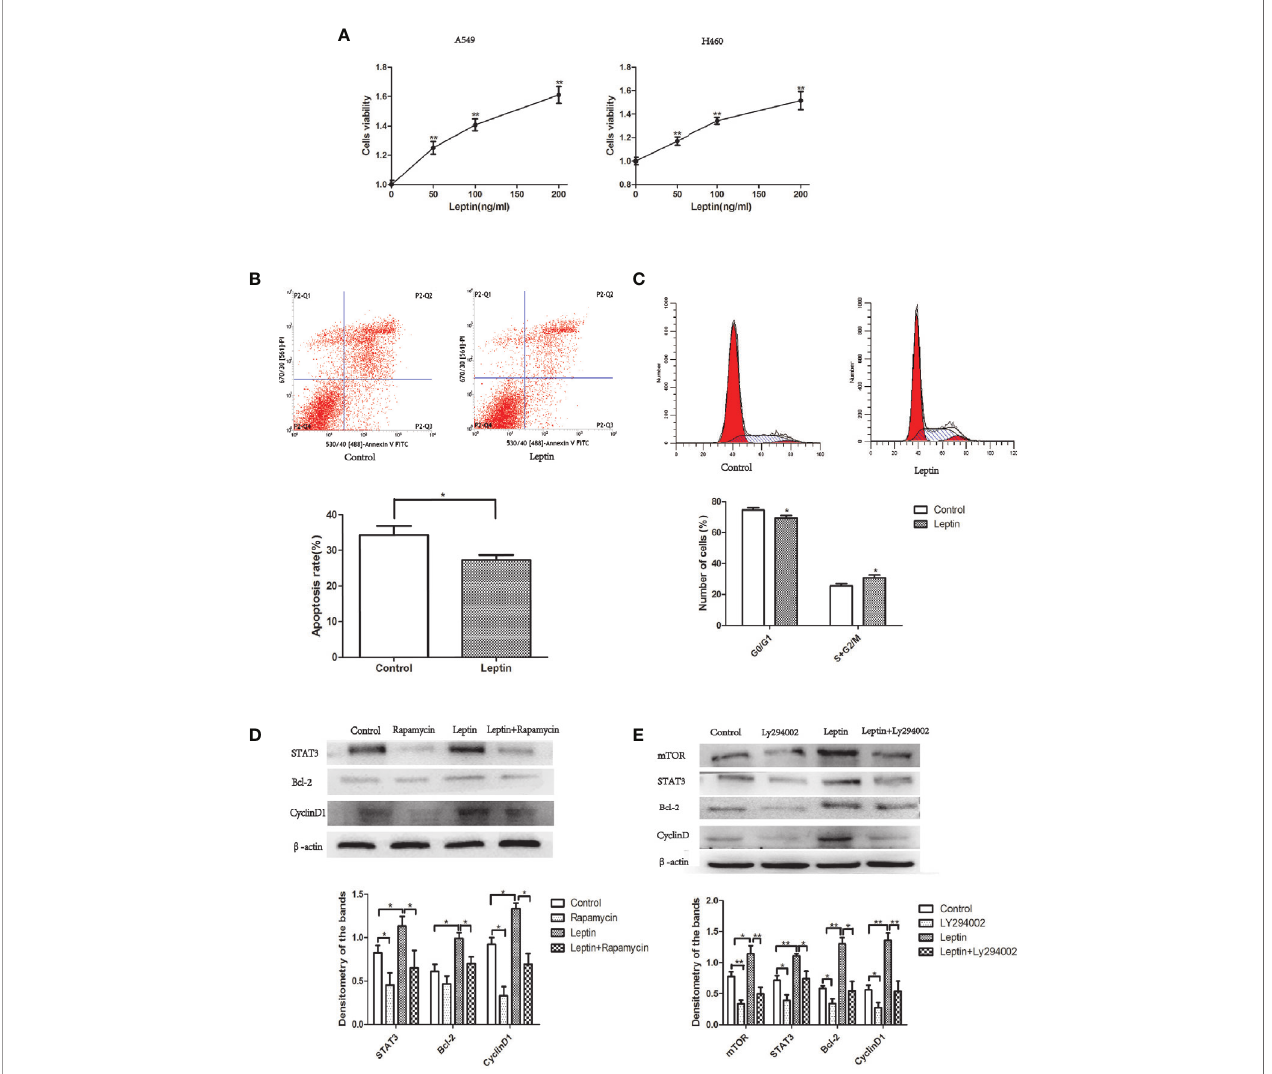
FIGURE 5 | Effect of leptin on lung cancer cell proliferation and apoptosis in vitro . (A) Cell viability increased in a dose-dependent manner when A549 or H460 cells were treated with increasing concentrations of leptin (0, 50, 100, and 200 ng/ml). (B) Proportion of apoptotic cells decreased when A549 was treated with 100 ng/ml leptin as measured by fl ow cytometry assays. Upper: representative image of fl ow cytometry assay. (C) Cell cycle changes were observed when A549 was treated with 100 ng/ml leptin. Upper: representative image of fl ow cytometry assay. (D) Western blotting for the expression of STAT3, Bcl-2, and CyclinD1 in A549 lung cancer cells with or without the inhibition of mTOR. (E) Western blotting for the expression of mTOR, STAT3, Bcl-2, and CyclinD1 in A549 lung cancer cells with or without the Inhibition of PI3K. All quanti fi cations are made from three individual experiments. *P < 0.05, **P <